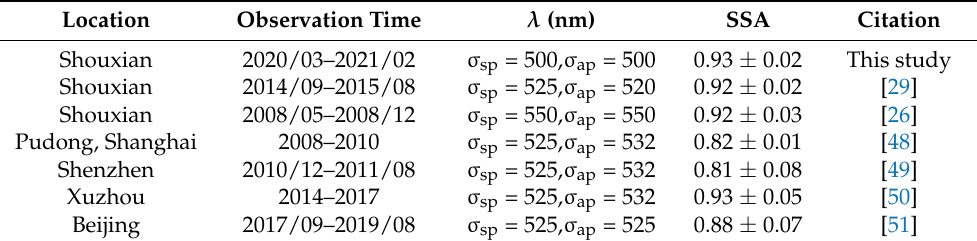
Table 3. Comparison of aerosol single scattering albedo in different studies. Location Observation Time